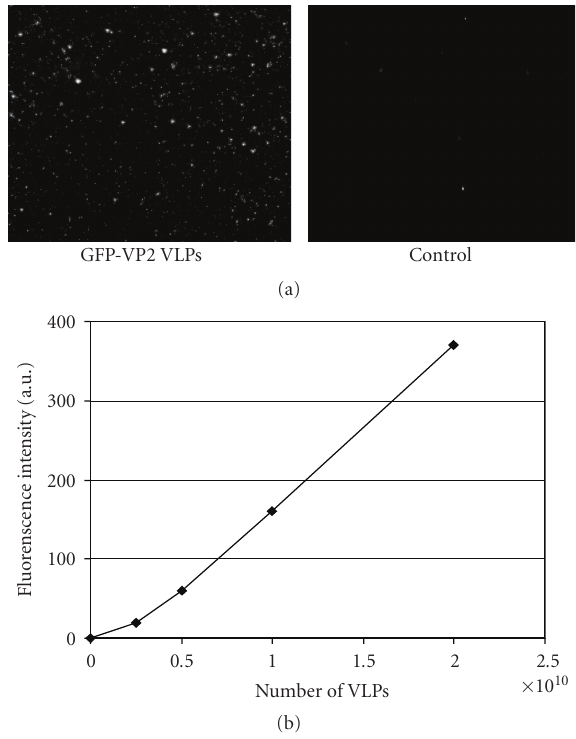
Figure 2: Quantification of VLP carrying GFP :VP2 fusion protein. (a) CsCl purified fluorescent VLP were concentrated by centrifu- gation and the pelleted VLP recovered in TNC bu ff er, spotted on glass slides, and visualized by confocal microscopy. TNC bu ff er was used as a control. (b) Increasing amounts of VLP-GFP, as measured by protein concentration, were placed in 96-well plaques and fluorescence intensity was measured by direct spectrofluorometry using a TECAN SpectraFluor. Results are representative of 3 independent